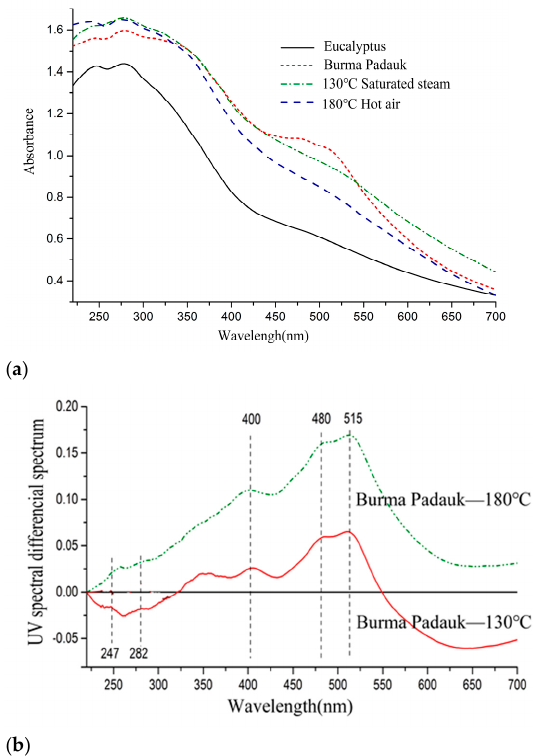
Figure 2. ( a ) UV–Vis spectra and ( b ) UV–Vis differential spectra of Eucalyptus and Burma padauk wood.